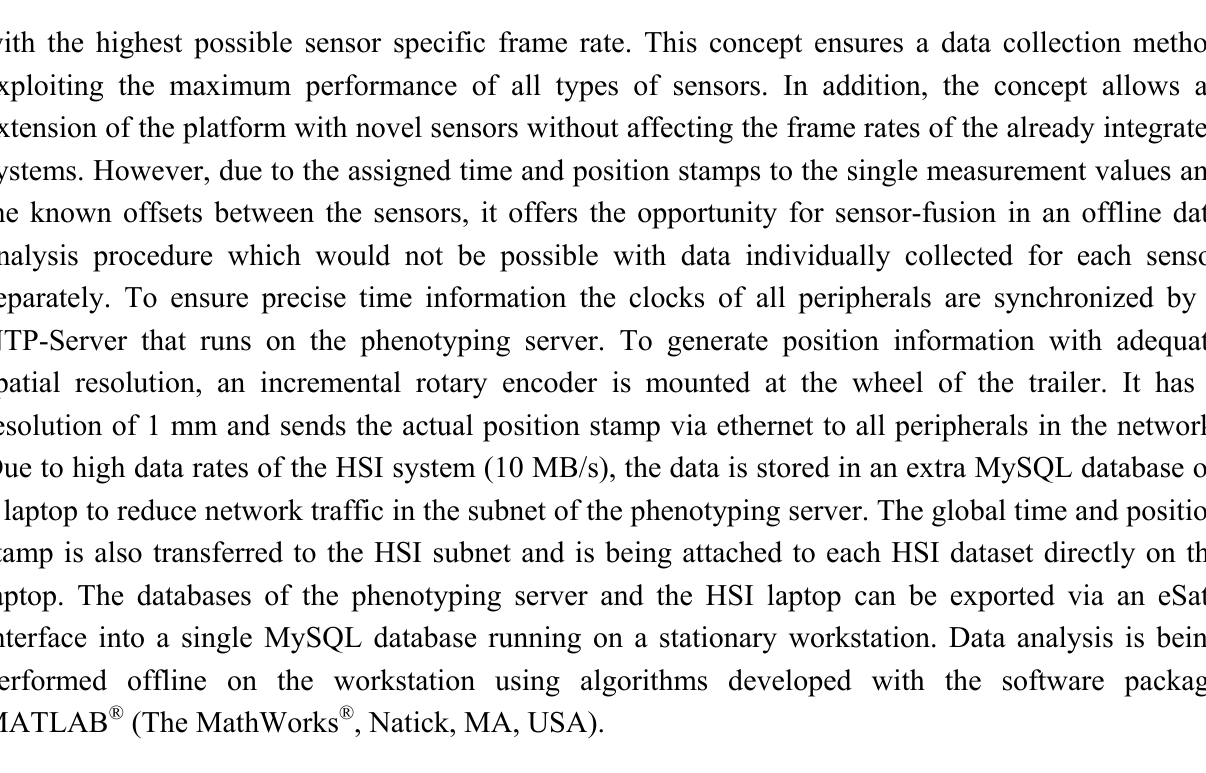
Figure 3. System architecture for data collection and